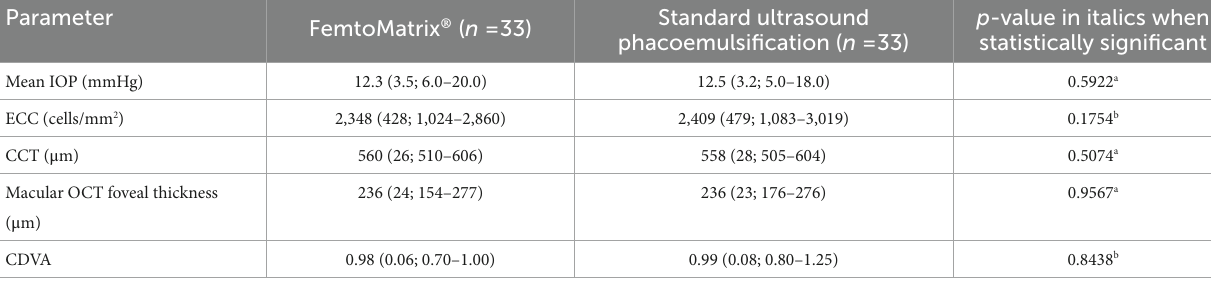
TABLE 3 Postoperative characteristics of the patients.